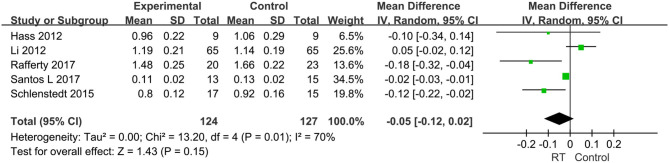
Forest plots of the effects of lower limb RT on gait performance—stride length in PD. CI, confidence interval.